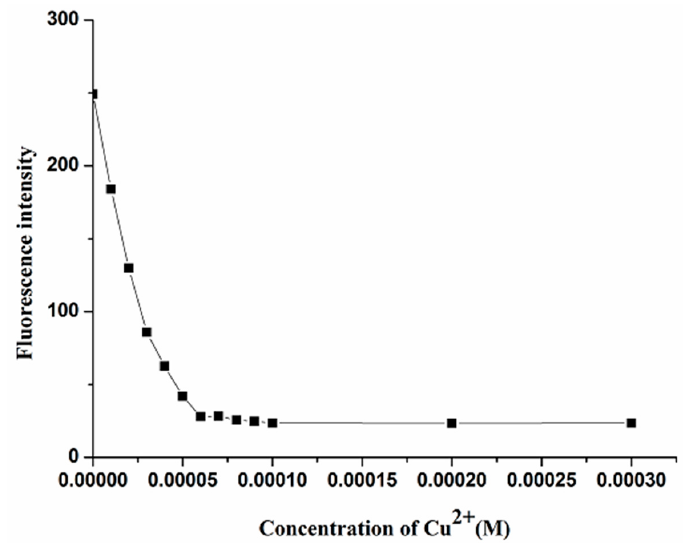
Figure 6. Fluorescence intensity vs Cu 2+ ; inset shows that up to 6-fold Cu 2+ curvilinearity was